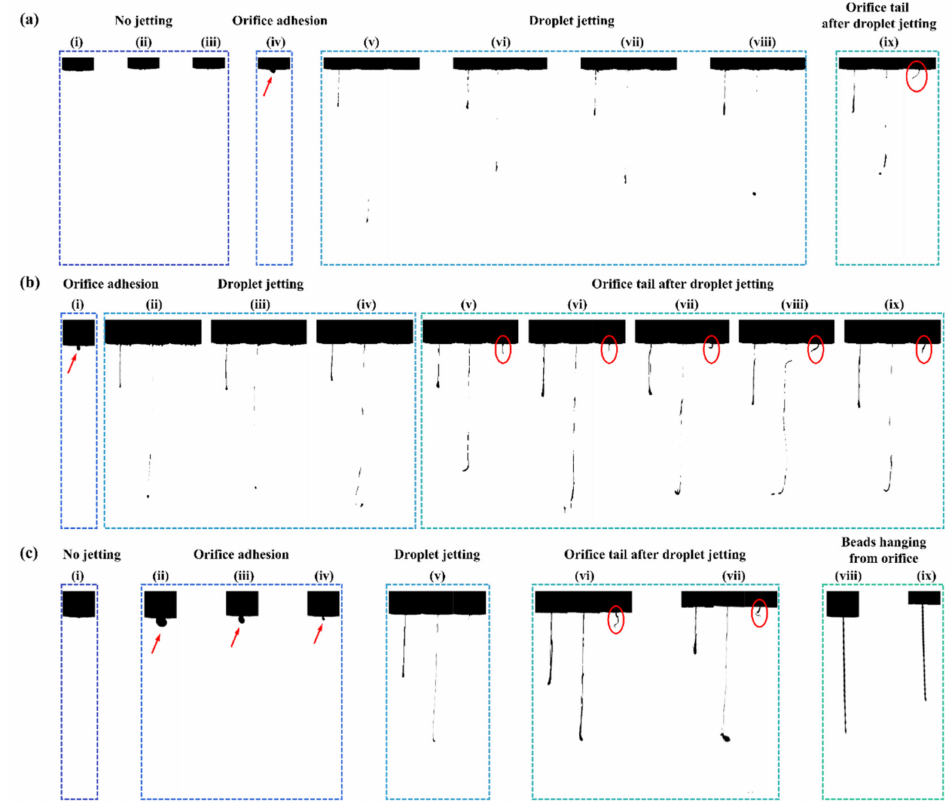
Figure 3. Jetting states with different input variables. ( a ) Operating pressure varying from 2 bar to 5.2 bar with increments of 0.4 bar (corresponding to ( i ) to ( ix )) and the preload angle and fluid pressure fixed at − 90 ◦ and 3.6 bar, respectively. ( b ) Fluid pressure varying from 2 bar to 5.2 bar with increments of 0.4 bar (corresponding to ( i ) to ( ix )) and the preload angle and operating pressure fixed at − 90 ◦ and 4.8 bar, respectively. ( c ) Preload angle varying from − 180 ◦ to 180 ◦ with increments of 45 ◦ (corresponding to ( i ) to ( ix )) and the operating pressure and fluid pressure fixed at 4.0 bar and 5.2 bar,